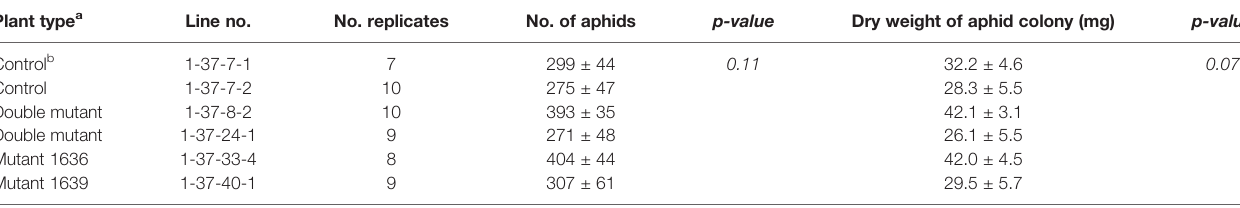
TABLE 4 | Aphid population size (mean ± SE) 15 d after release of one female R. padi per plant. Plant type a Line